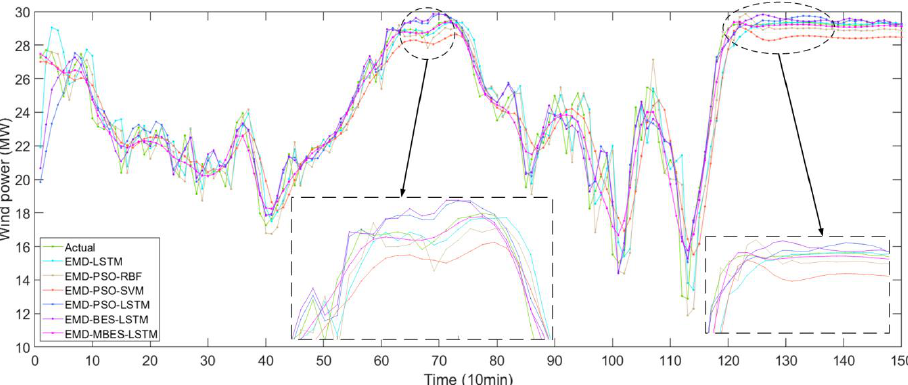
Figure 7. The forecasting results of different models based on EMD. In Figures 6 and 7, the solid green line represent the actual values, while the remain- ing six colored lines represent the forecasted values. The closer their location to the green line, the higher the forecasting accuracy of the models. An observation can be made that the forecasting value line of the MBES-LSTM model was closer to the green line, which indicates that the forecasting precision of MBES-LSTM was the highest. In order to more intuitively reflect the size of the forecasting error, a box-plot was drawn to graphically present the forecasting error, as shown in Figure 8. According to the box-plot, the MBES-LSTM model based on EMD showed less errors.